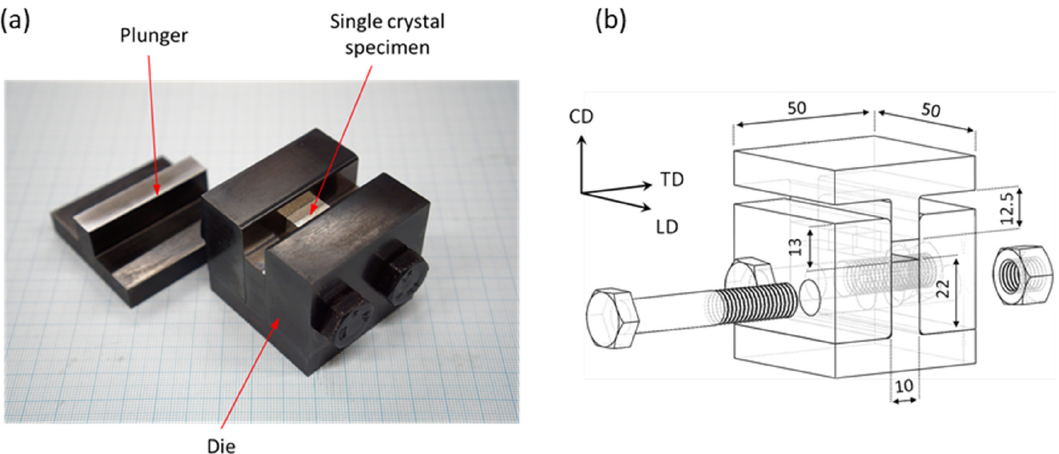
Figure 2. ( a ) Channel ‐ die device used for plane strain compression tests with a Mg specimen; ( b ) schematic illustration of the channel die in a) (LD—longitudinal direction, TD—transverse direc ‐ tion, CD—compression direction). Measurements are given in mm.